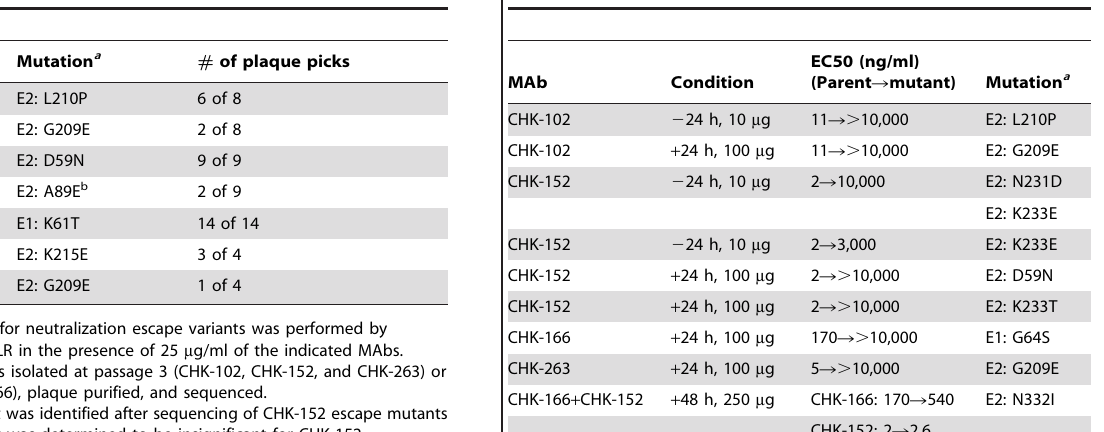
Table 2. In vitro selection of viruses resistant to MAb neutralization.